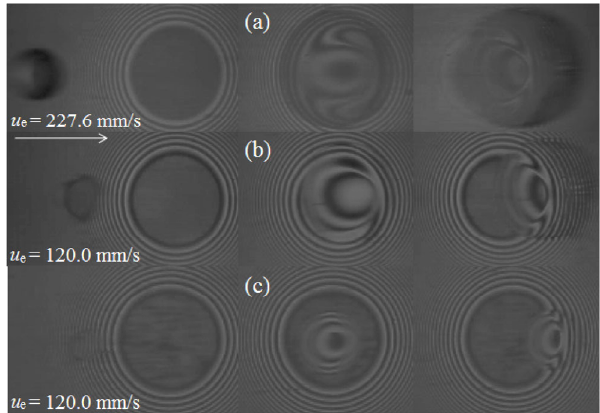
Fig. 15 Lubrication process with different dimple size and speed, PAO100: (a) D ini = 187 μ m; (b) D ini = 143 μ m; (c) D ini = 87 μ m, w = 30 N.